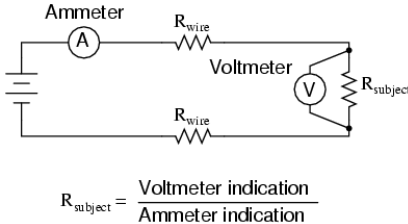
Figure 4. Schematic of four-wire resistance measurement.